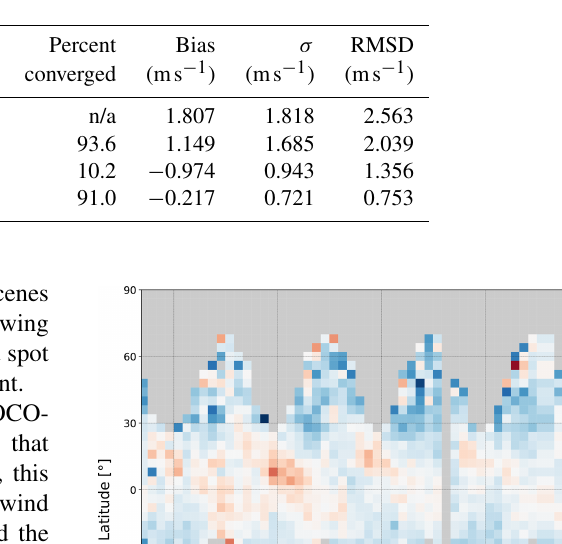
Table 1. Summary of the retrieval tests performed. Percent converged represents the fraction of converged soundings for the three retrieval variants, which were run on a set of soundings that were chosen to contain only high-quality soundings. The TSIS solar test was run on a slightly different set of soundings than the three- and single-band Cox–Munk-only tests. The ACOS B9 retrieval was run on a very large set of less filtered soundings and the percent of converged soundings is not comparable to the other three tests, so it is listed as “not applicable” (n/a).